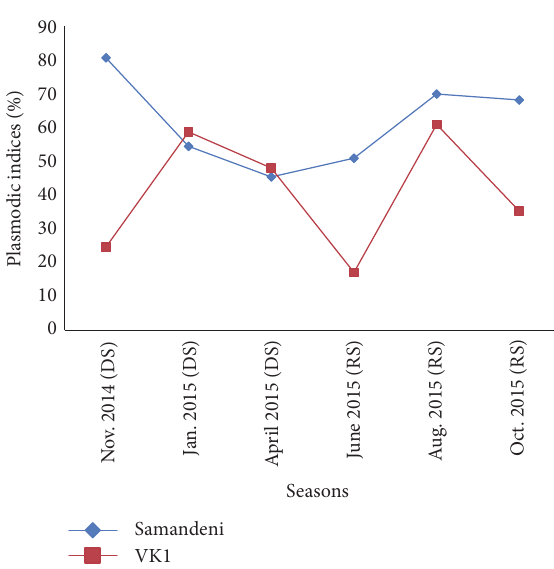
Figure 2: Seasonal variation of plasmodic indices of study sites. DS: dry season; RS: rainy season; the blue curve: seasonal variation of Samandeni children’s plasmodic index; the red curve: seasonal variation of the VK1 children’s plasmodic index.